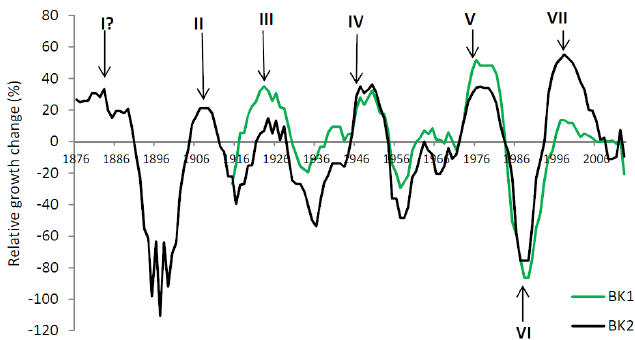
Figure 5. Running relative growth changes (releases) of Pinus sylvestris from Bagno Kusowo (BK1 and BK2). The relative growth change was calculated as the % difference between the mean ring-width in 10 preceding years and the mean in 10 subsequent years. I, II, III, and IV = phases of bog drainage; V, VI, and VII = phases associated with other factors (forest management practices, outbreak, fires).